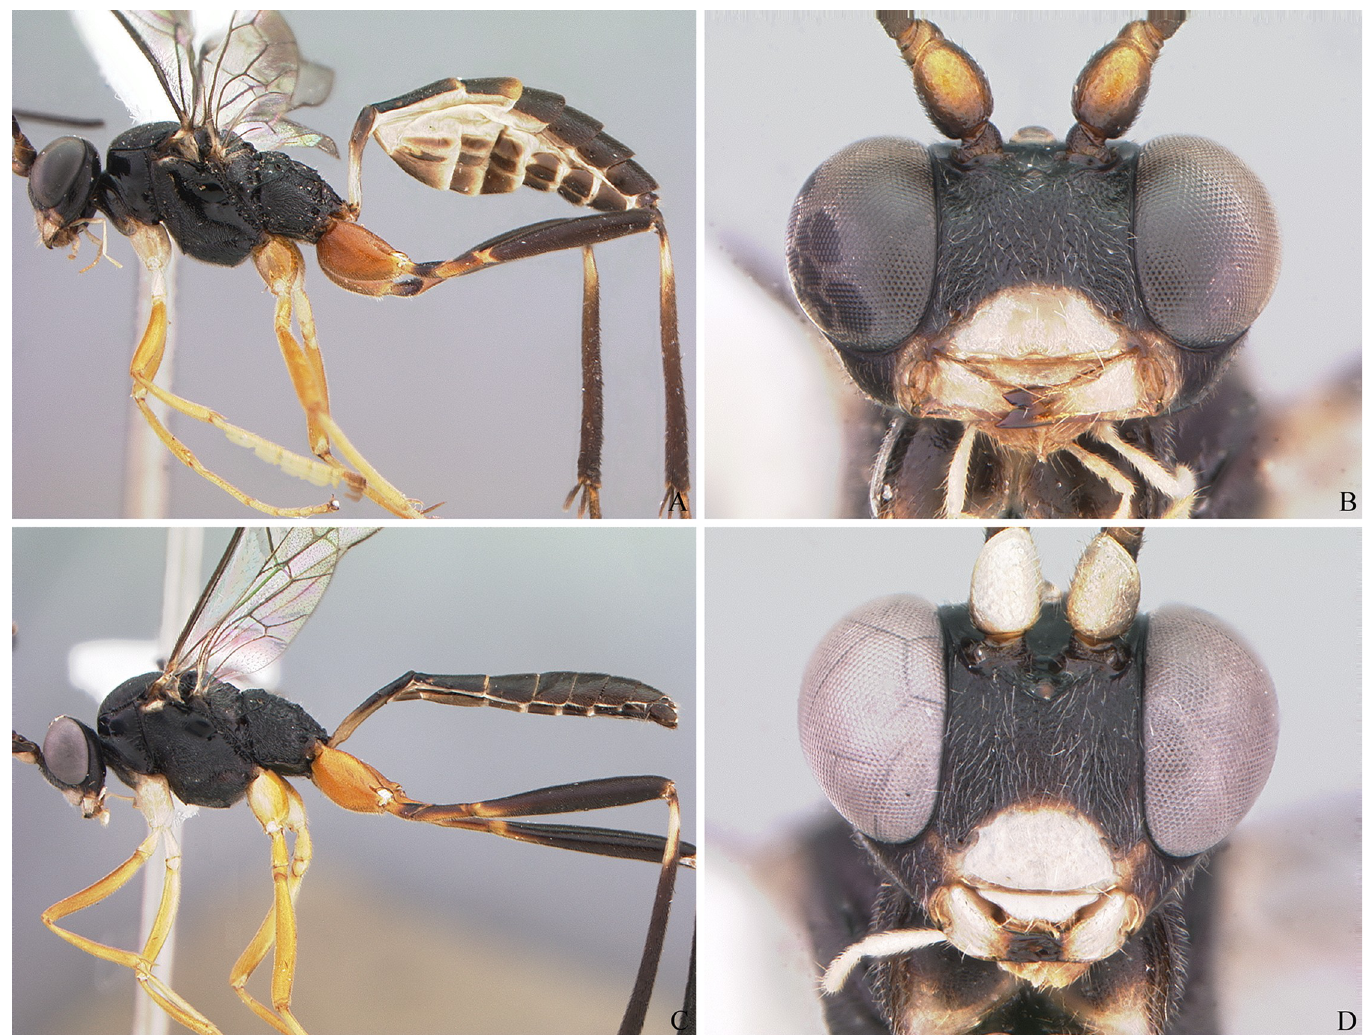
Fig 19. Comparison between a male Cryptoxenodon metamorphus sp. nov. (top) and a similar Diapetimorpha sp. collected in the same reserve (bottom). (A-B) Habitus and head in frontal view; paratype, FAS4618, Alt. 17m, Brazil/PA. (C-D), Habitus and head in frontal view; Diapetimorpha sp., FAS4619, Alt. 16m, Brazil/PA.